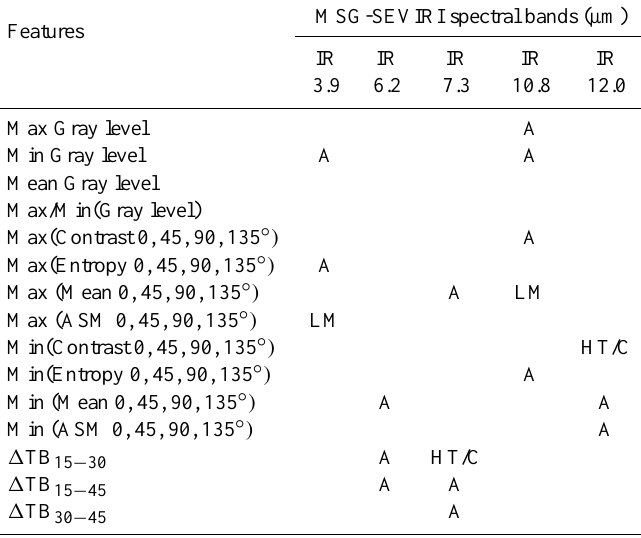
Table 6. Summary of the features considered for use in the RainCEIV k -NNM classifier during nighttime. Label “A” means that the feature is used for all the C-MACSP classes; “LM” means that the feature is used for the low/middle cloud class; “HT/C” means that the feature is used for the high thick and convective cloud class.